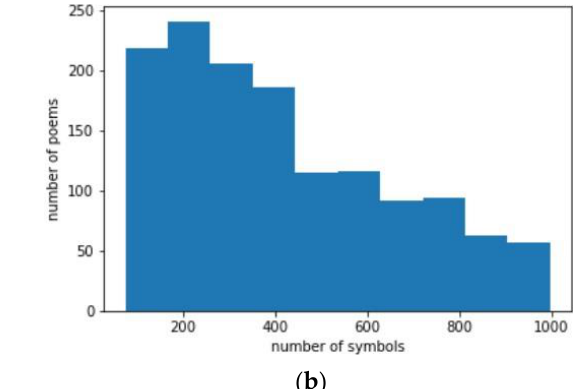
Table 2. Data set of poems by poets of the Pushkin